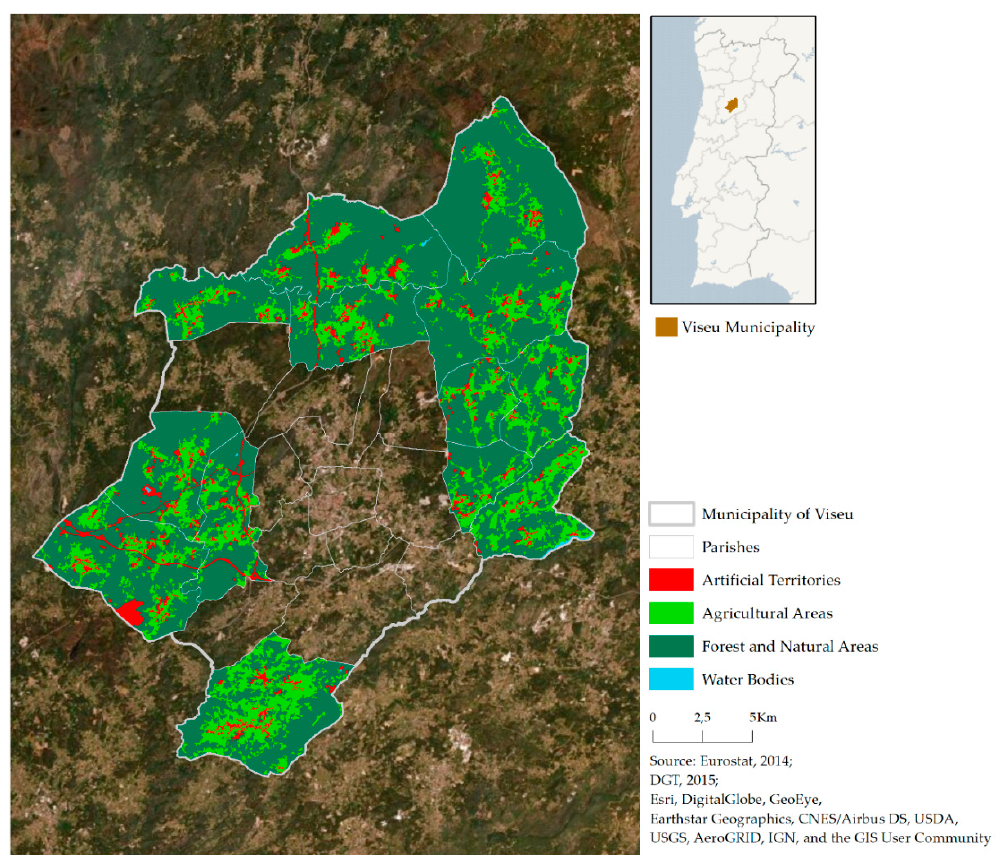
Figure 10. Parishes with a different classification between DEGURBA and TIPAU (Code 1 and APR, respectively), and land use in 2015.